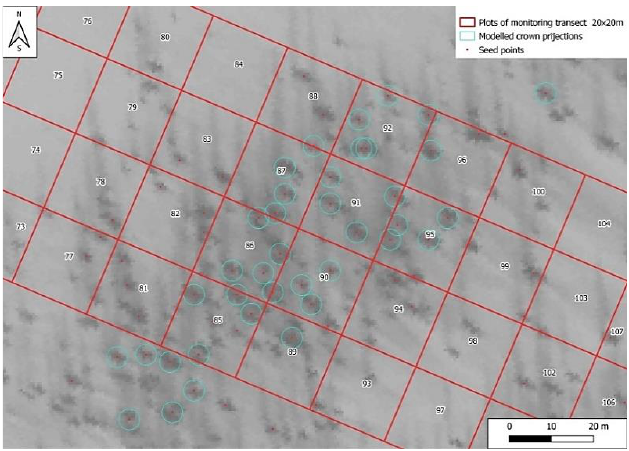
Figure 4. Tree crown projection simulated using segmentation data of winter satellite images taken with WorldView 2007.